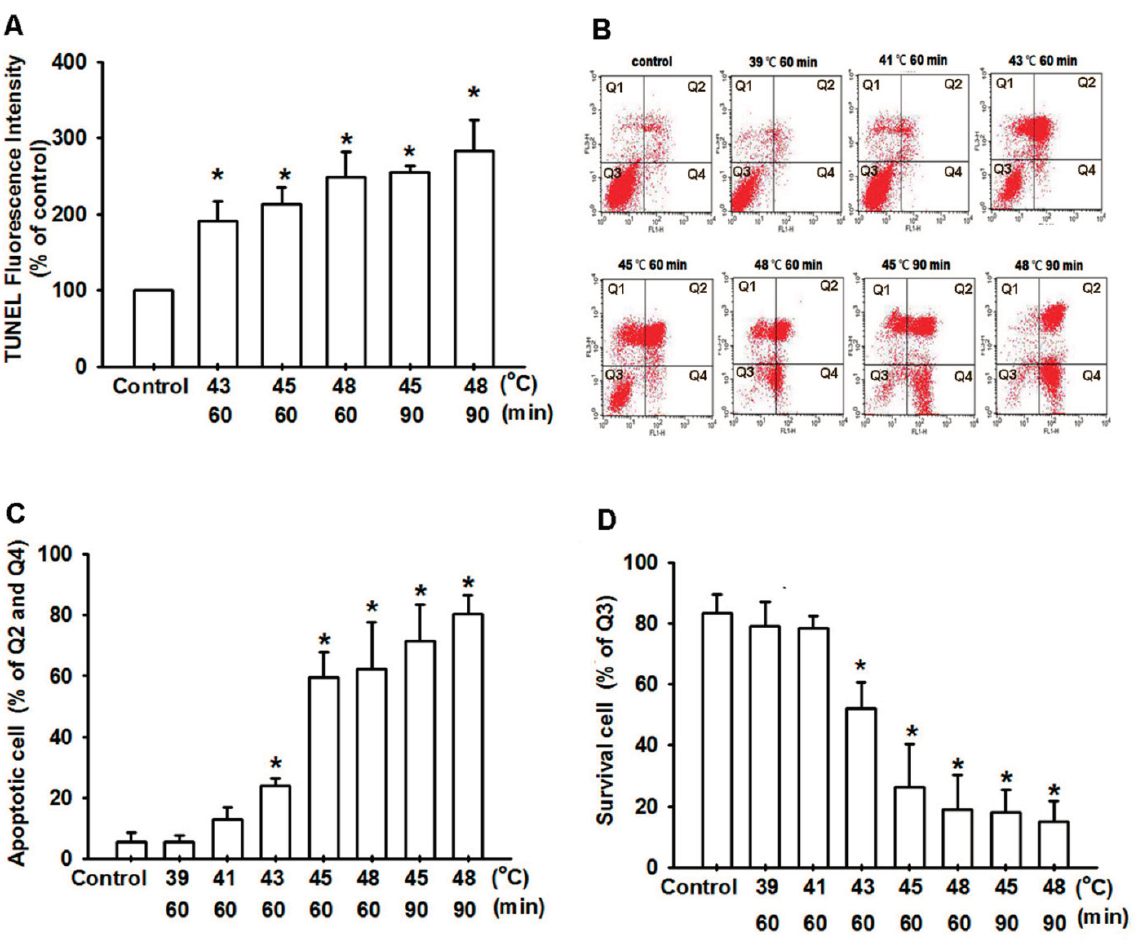
Figure 2. Hyperthermia-induced apoptosis of human OS cells. ( A ) Cells were treated at various temperatures of hyperthermic conditions. After 24 h, TUNEL-positive cells were examined using flow cytometry; ( B – D ) U-2 OS cells were treated at various temperatures of hyperthermic conditions. After 24 h, the percentage of apoptotic cells was analyzed by conducting flow cytometric analysis on Annexin V/PI double staining. The results are expressed as the mean ± SEM of 4 independent experiments. * , p < 0.05 compared with the control group.